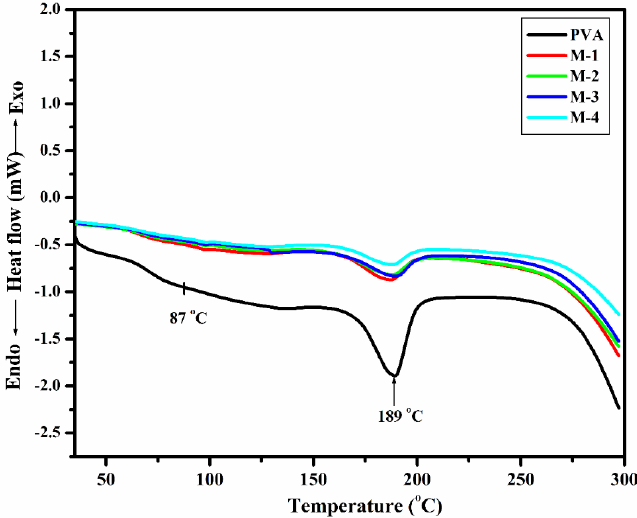
Figure 4. DSC thermograms of PVA and CS-capped AgNP-incorporated PVA hybrid membranes: (M-1) 0.5 wt.%; (M-2) 1 wt.%; (M-3) 1.5 wt.%; (M-4) 2 wt.% of CS-capped